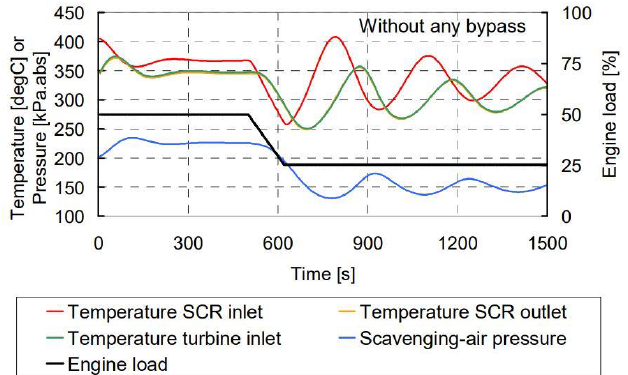
Figure 12. Matching situation between low-speed diesel engine and HP-SCR system under variable operating conditions [136].